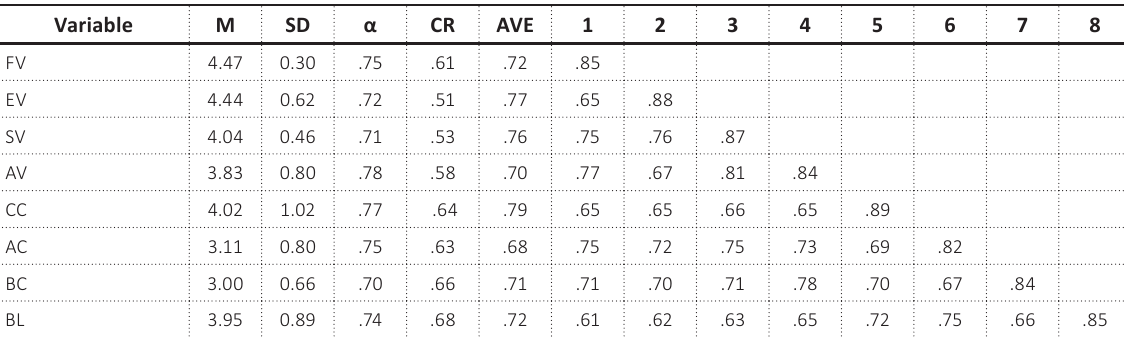
Table 1. Descriptive statistics, coefficient alphas, composite reliability, average variances extracted, and zero-order